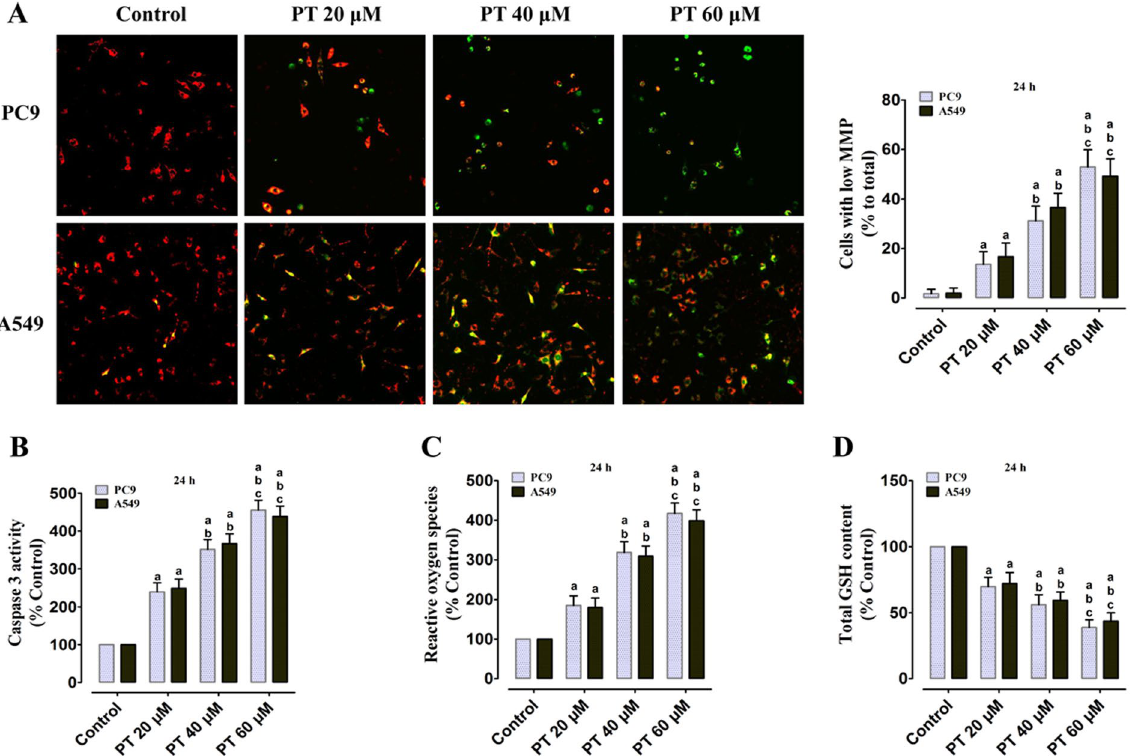
Figure 3. Effect of PT treatment on the depolarization of mitochondrial membrane, Caspase 3 activity, ROS generation, and GSH level in PC9 and A549 cells (24 h). ( A ) Representative merged images of JC-1 red ( normal MMP )/green ( low MMP ) cells, and the MMP levels were expressed as the proportion of cells with a low MMP. ( B ) Intracellular Caspase 3 activity; ( C ) ROS concentration; ( D ) Intracellular GSH level; and those three indexes in the control group were defined as 100%. All of the results were expressed as the mean ± SD; n = 6. a P < 0.05 vs . the control group, b P < 0.05 vs . the 20 μ M PT-treated group, c P < 0.05 vs . the 40 μ M PT-treated